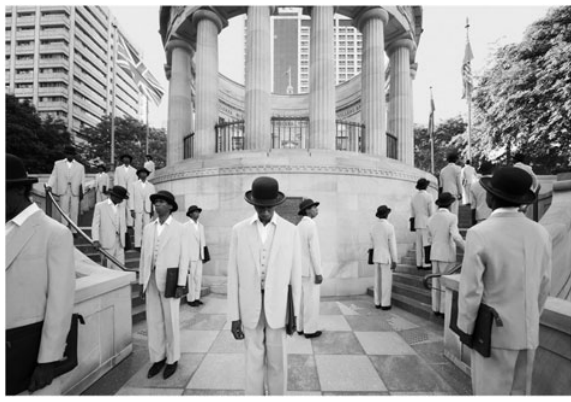
Fig. 1. Michael Cook, Majority Rule (Memorial) 2014, inkjet print on paper. Reproduced courtesy of the artist and UQ Art